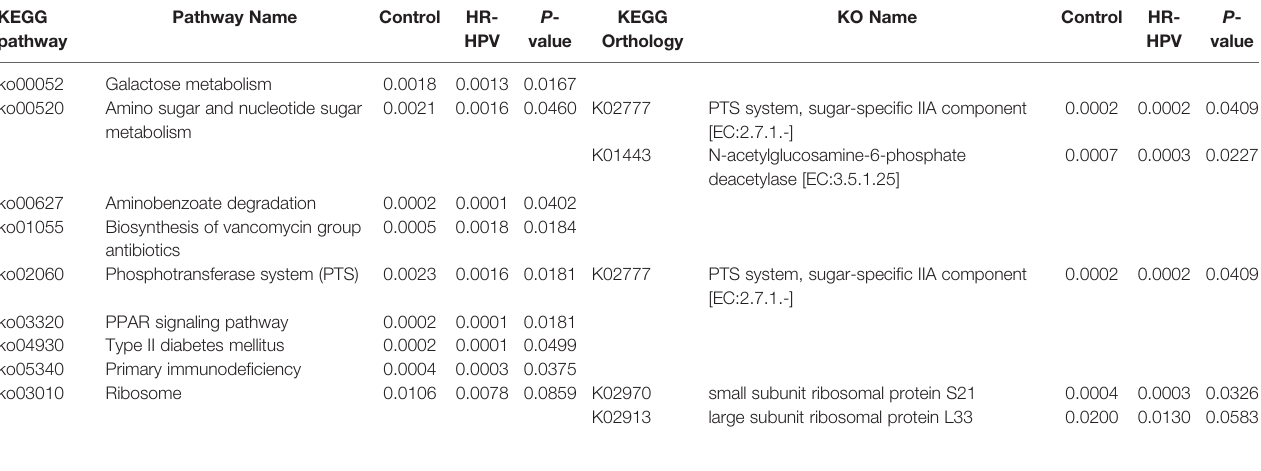
TABLE 2 | Relative abundance of nine KEGG pathways and four KEGG orthologies (KOs). KEGG